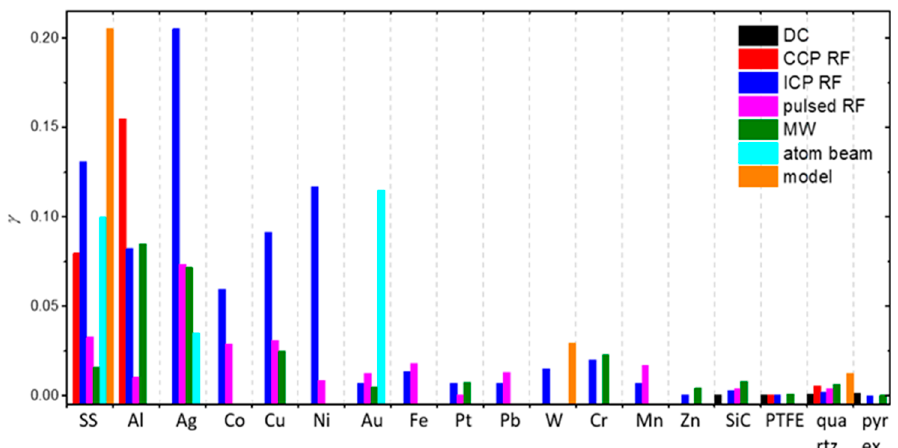
Materials 2023 , 16 , x FOR PEER REVIEW 35 of 51 Figure 14. Comparison of average reported recombination coefficients for the most commonly studied materials in various plasma systems.